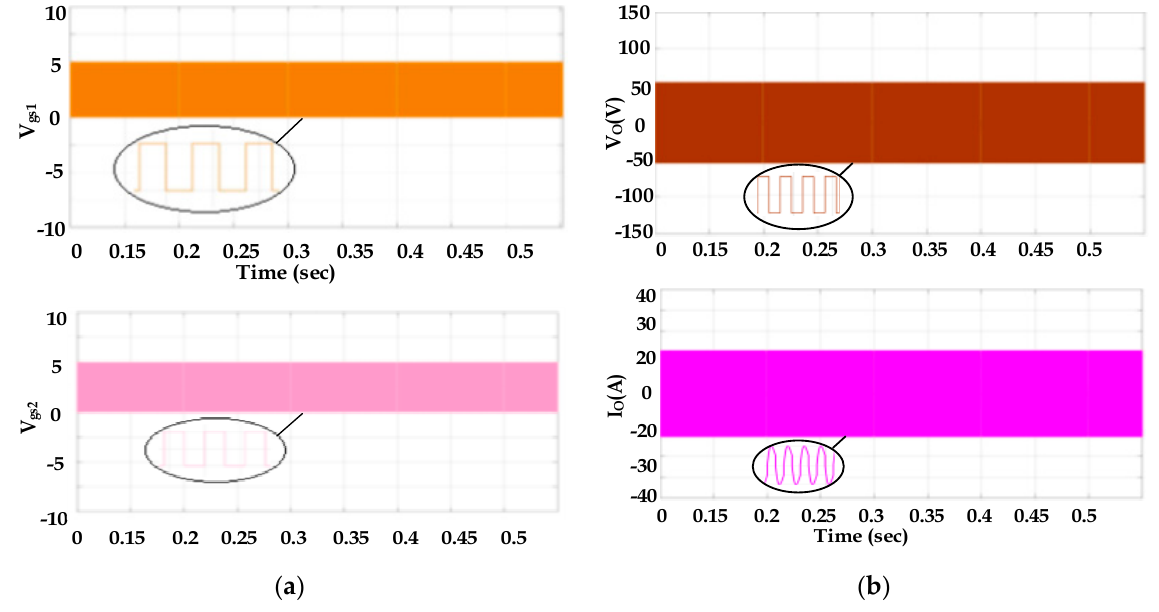
Figure 10. Simulation waveforms of Mode 1 with 100% PDM: ( a ) switching pulses and ( b ) output voltage and current.